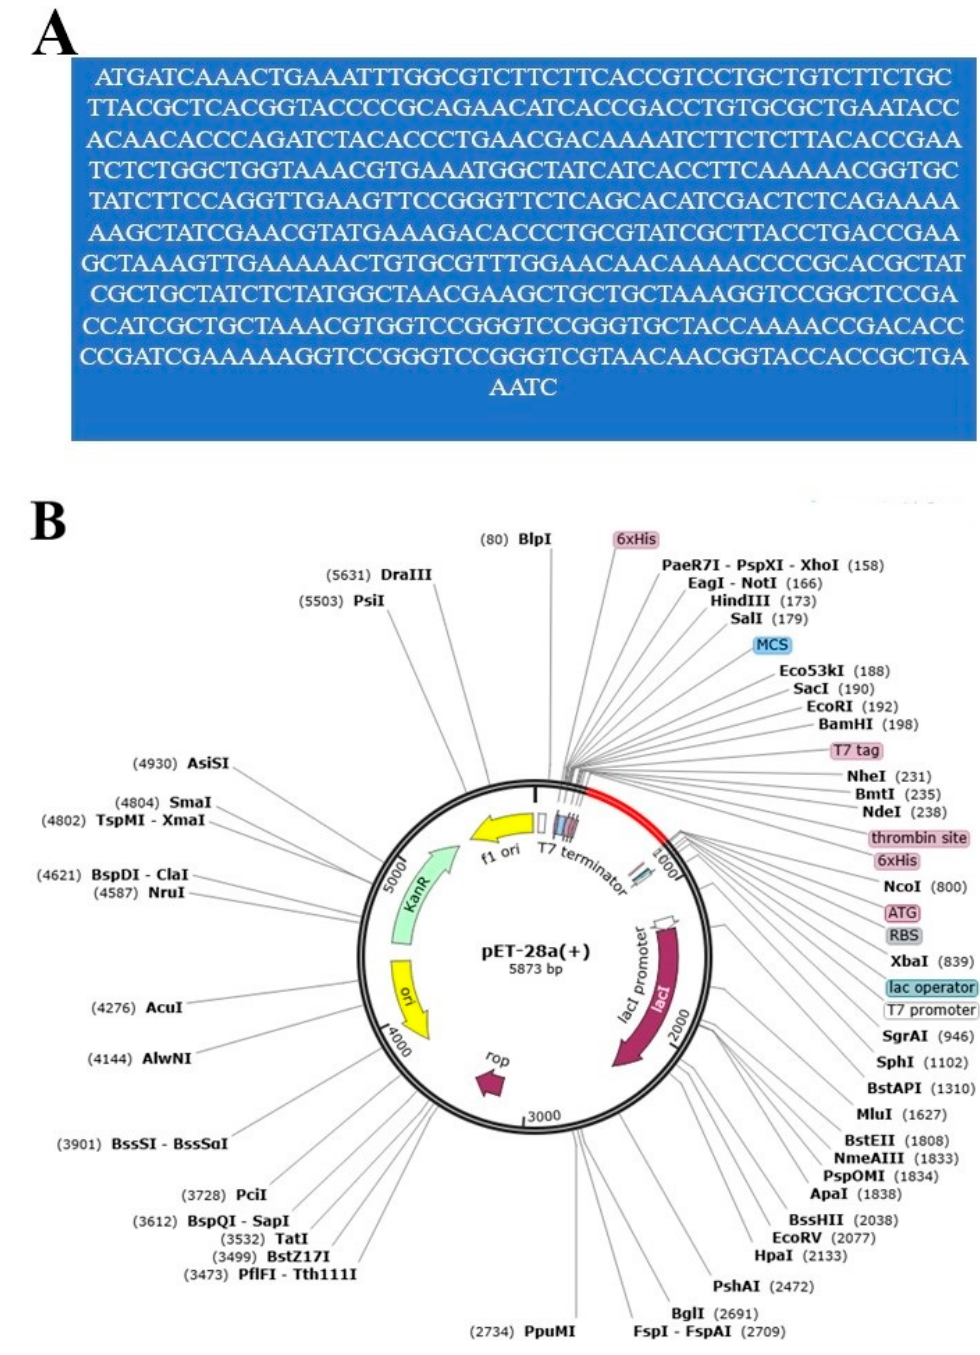
Figure 10. Codon optimization and cloning analysis of vaccine. ( A ) DNA sequence of the vaccine ( B ) In silico cloned pET28a (+) vector.